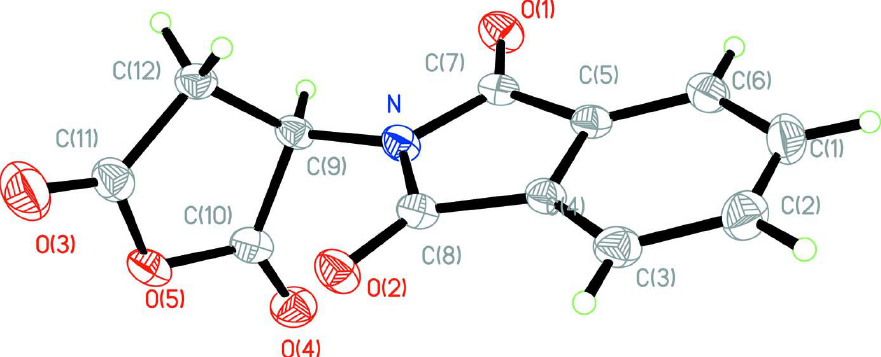
The structure of the title compound, showing the atom-labelling scheme. Displacement ellipsoids are drawn at the 35% probability